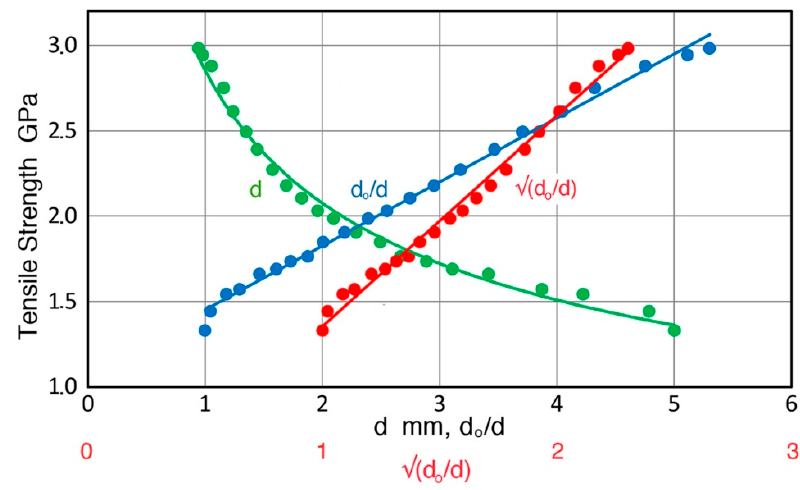
Figure 3. Tensile strength versus length parameters. Makii data [48]. Green plot: σ ts versus d ; Red: σ ts versus √ ( d o / d ), Blue: σ ts versus ( d o / d ).